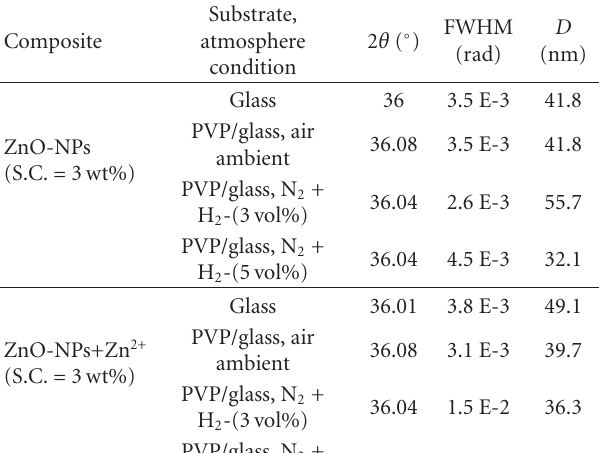
Figure 8: Leakage current density-voltage characteristic of the inkjet-printed gate dielectric layer. Optical microscopy image and thickness measurement of the inkjet-printed dielectric layer on ITO/glass (plain